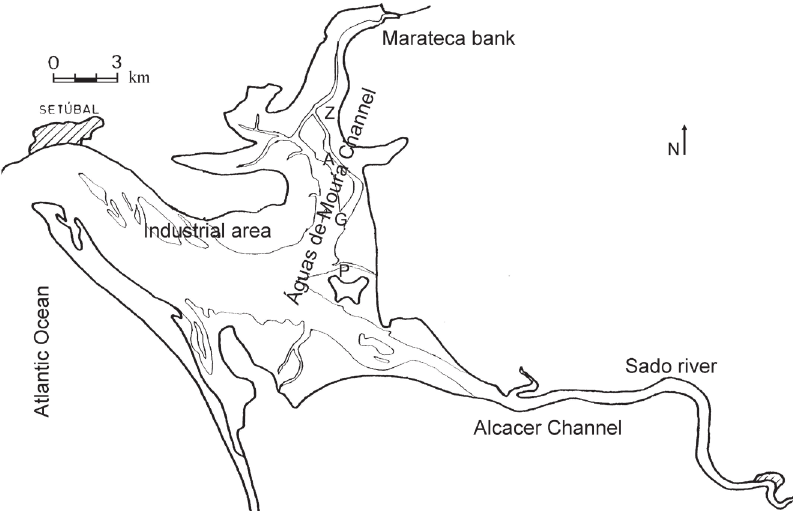
Fig . 1. – sado estuary, south Portugal. letters and points indicate sampling sites: Z, Zambujal; a, arrábidas; G, Garças; P,